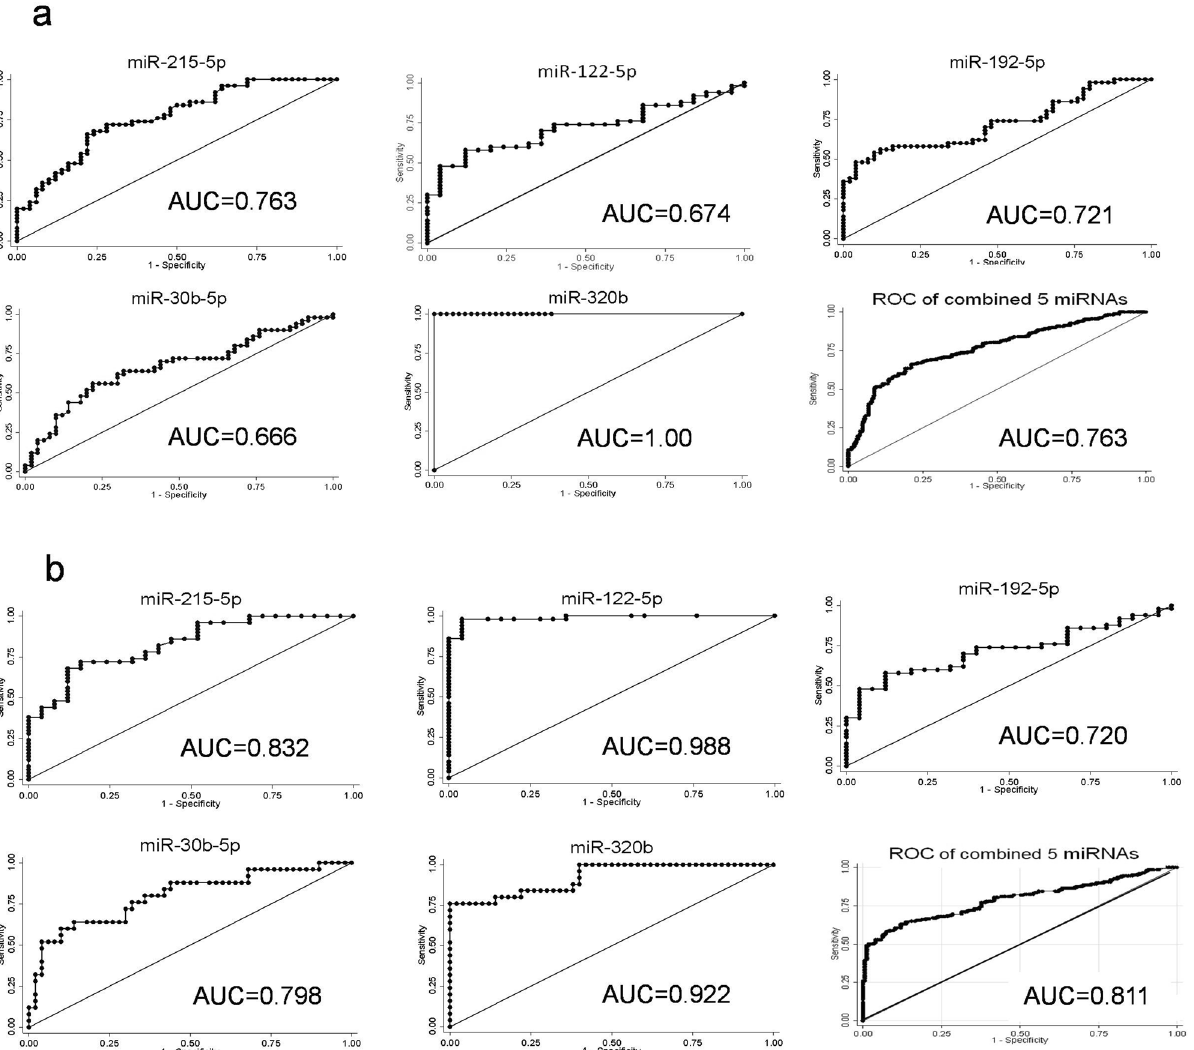
Figure 3. Receiver operating characteristic (ROC) curves of serum miRNAs based on results obtained by qRT- PCR ( a ) patients with PDAC versus CP, ( b ) patients with PDAC versus